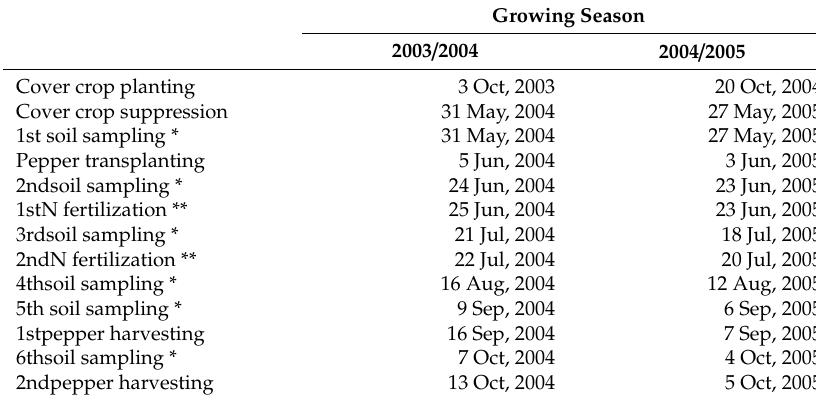
Table 1. Main field operations and sampling dates during the